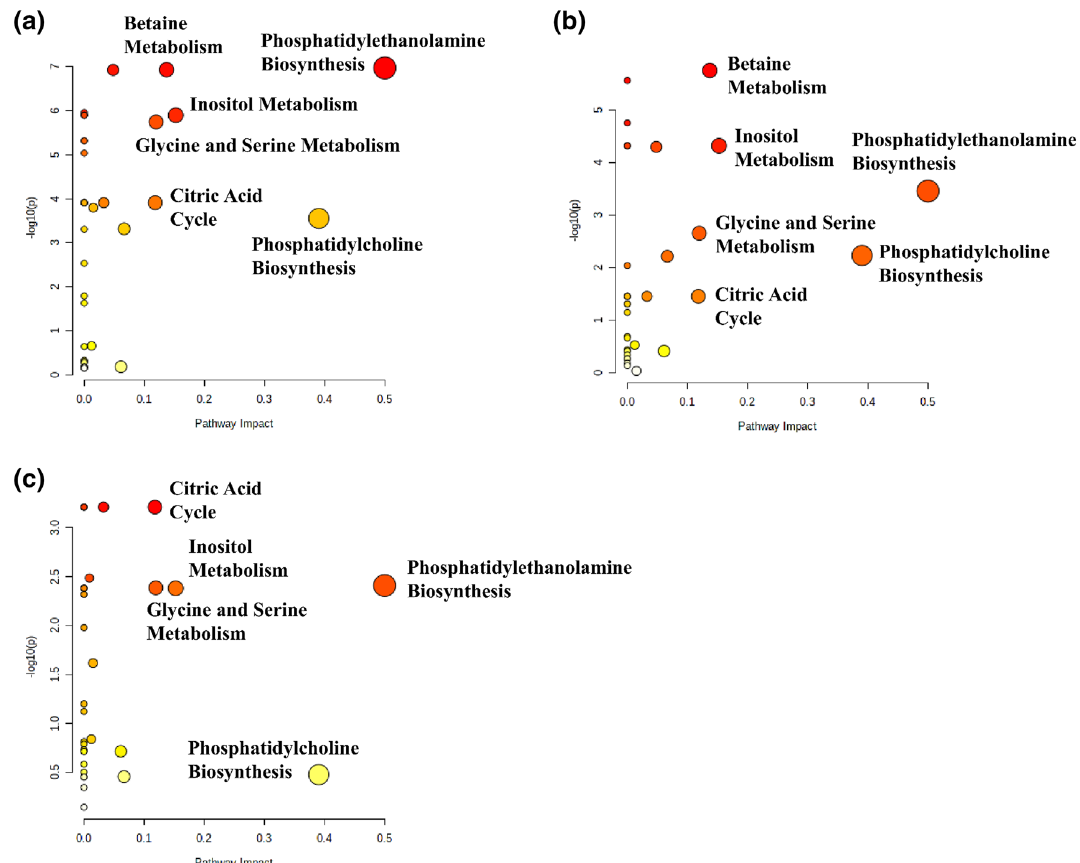
Figure 9. Metabolome views obtained from the pathways analysis presenting the pathways altered in EC: ( a ) G1 vs. G3, ( b ) G2 vs. G3 ( c ) G1 vs. G2. The image was created using Metaboanalyst 4.0 software (https:// www. metab oanal yst.